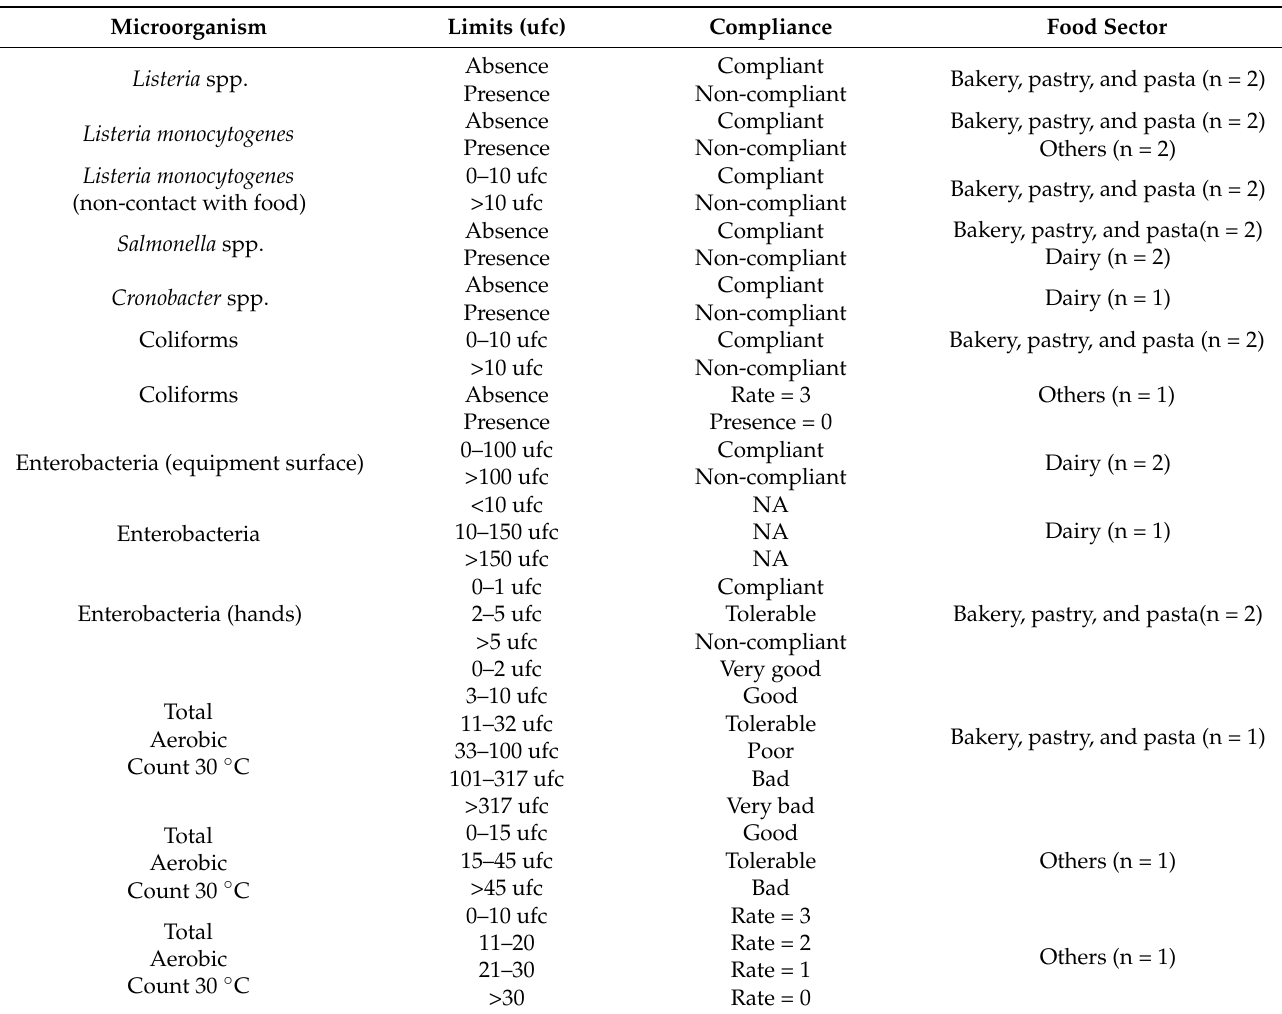
Table 2. Grid of decision for compliance in microbiological monitoring on surfaces reported by the agri-food industries surveyed. NA: Not